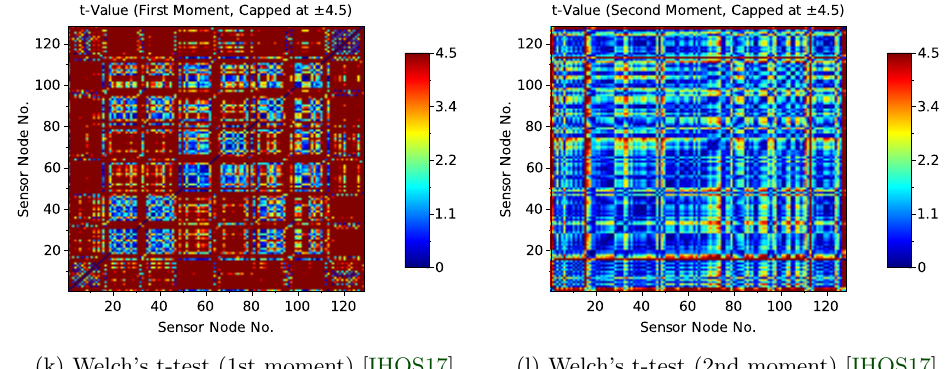
Figure 14: Statistical evaluation of 115 flexPCB covers (differential